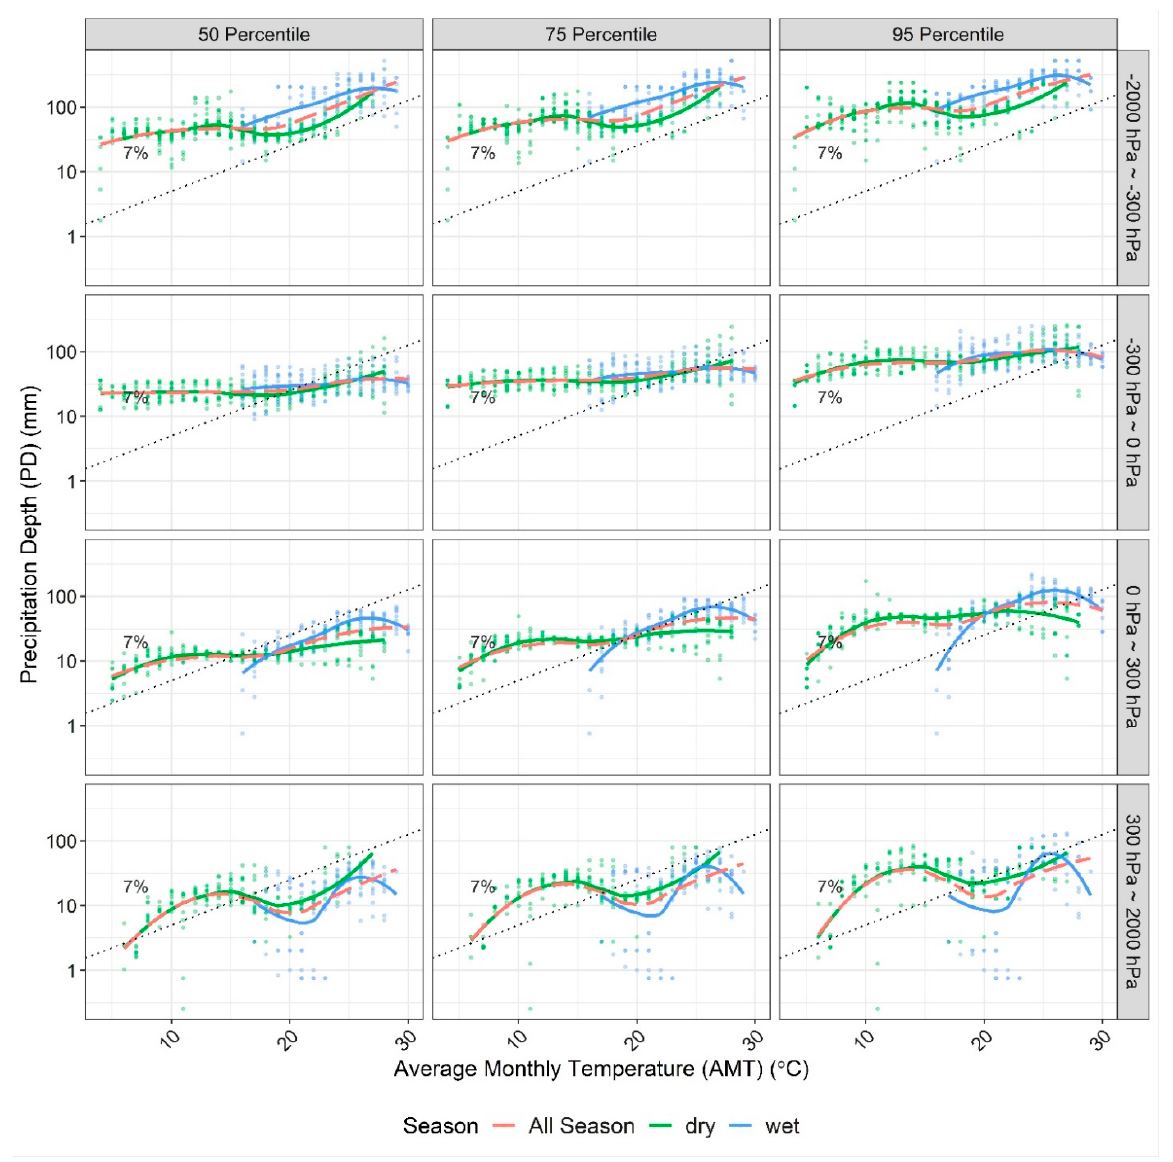
Figure 5. Seasonal relationships between precipitation depth (PD), average monthly temperature (AMT), and cumulative event pressure change (CEPC) in different